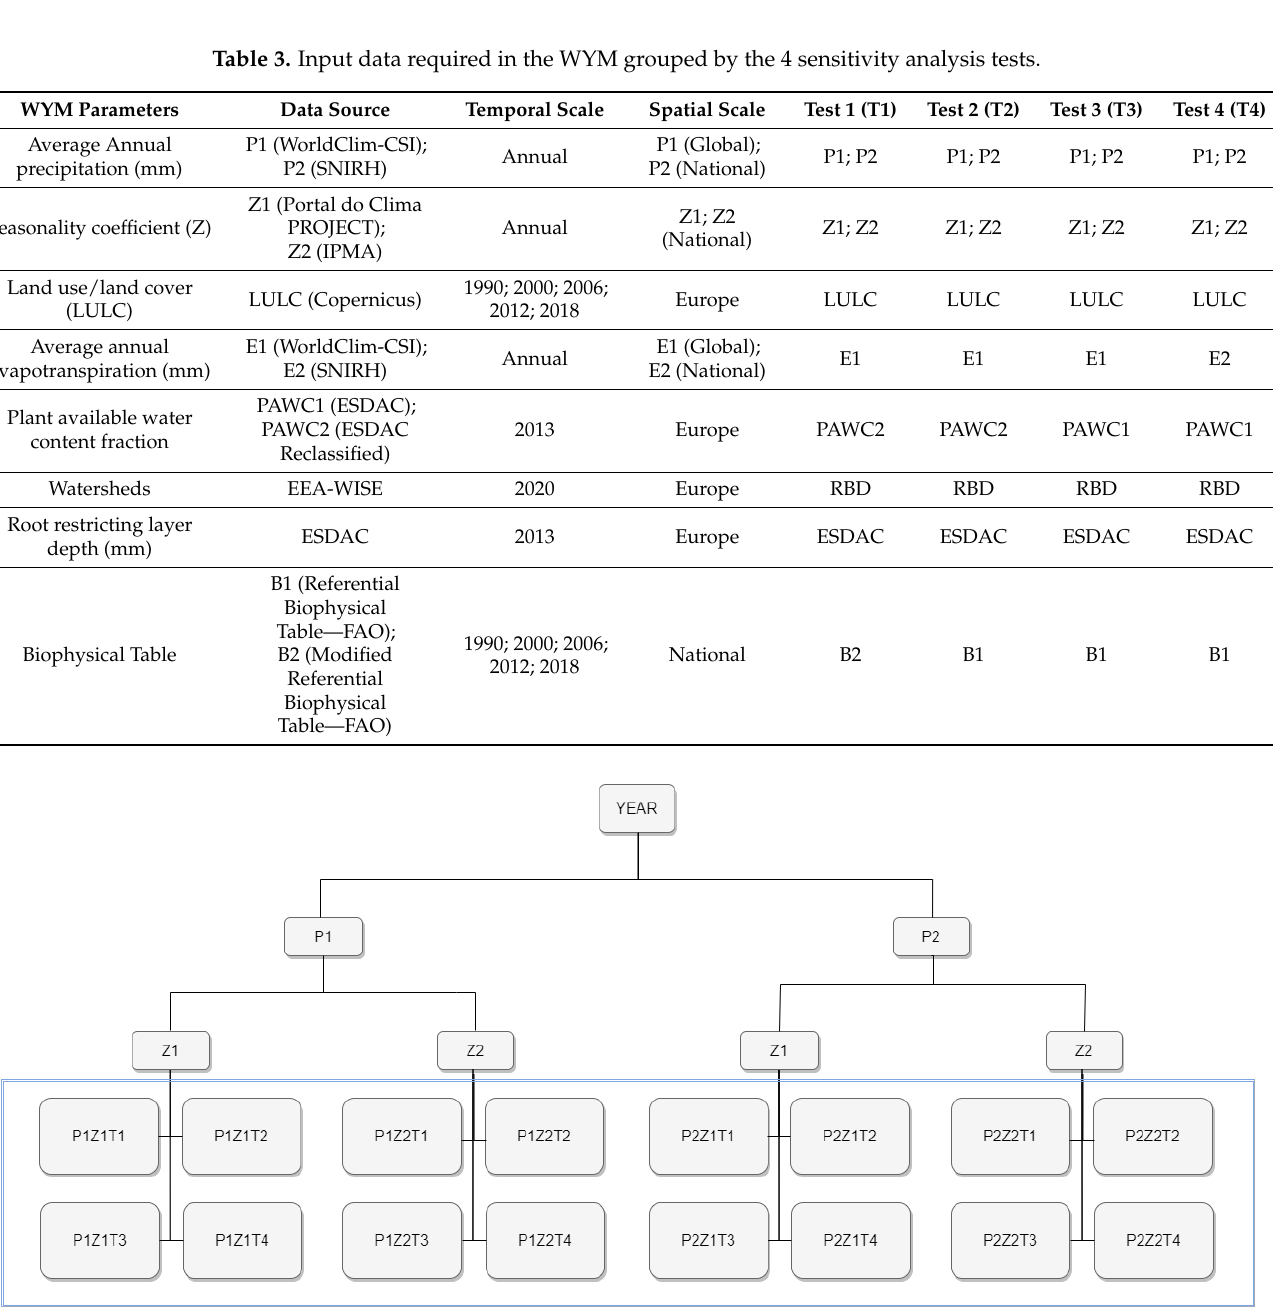
Figure 3. Diagram flow representing the sensitivity analysis tests applied to the InVEST WYM for years (1990, 2000, 2012, and 2018).